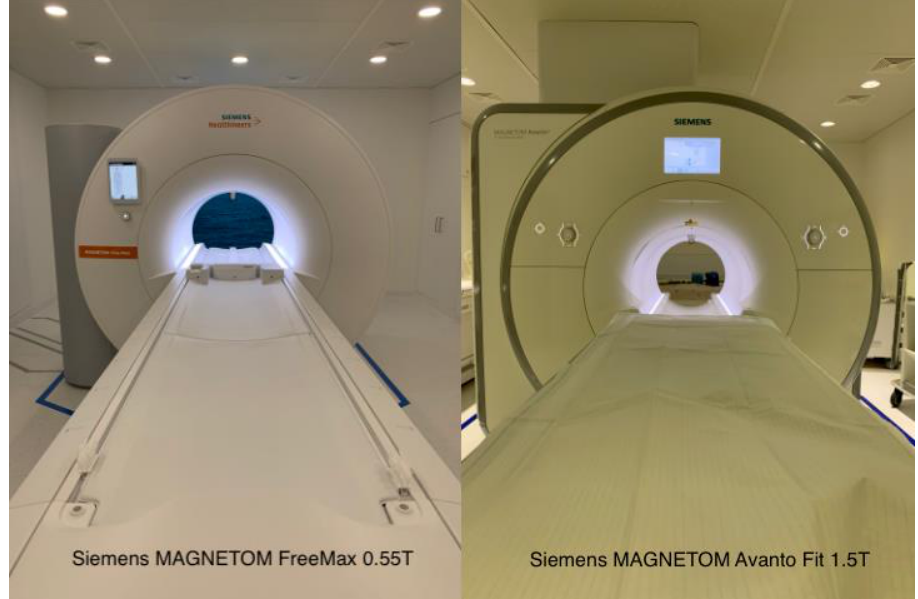
Figure 1. Overview of the patients included and their distribution among the study regions.